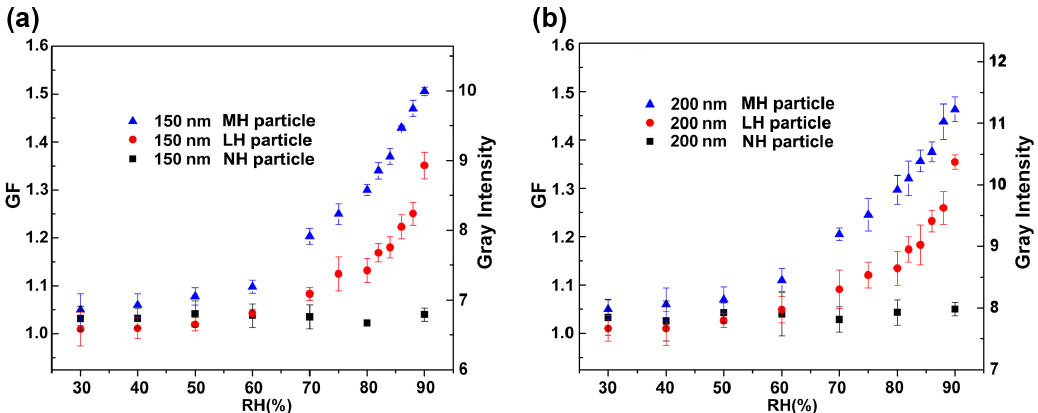
Figure 5. SPRM-ARI hygroscopic growth factors of (a) 150nm and (b) 200nm atmospheric particles on 28 September 2021.